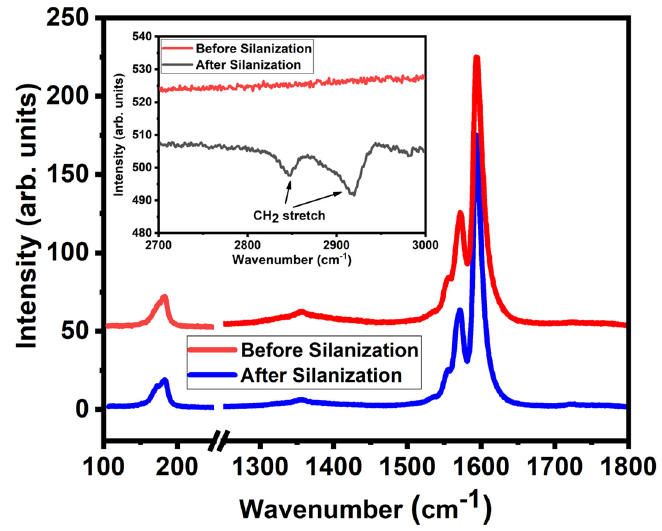
Figure 3. Raman shifts of radial breathing mode, D mode and G mode before and after silanization. Excitation wavelength: 473 nm. Spectra are normalized with respect to G-mode intensity. Inset: FT–IR before and after silanization.